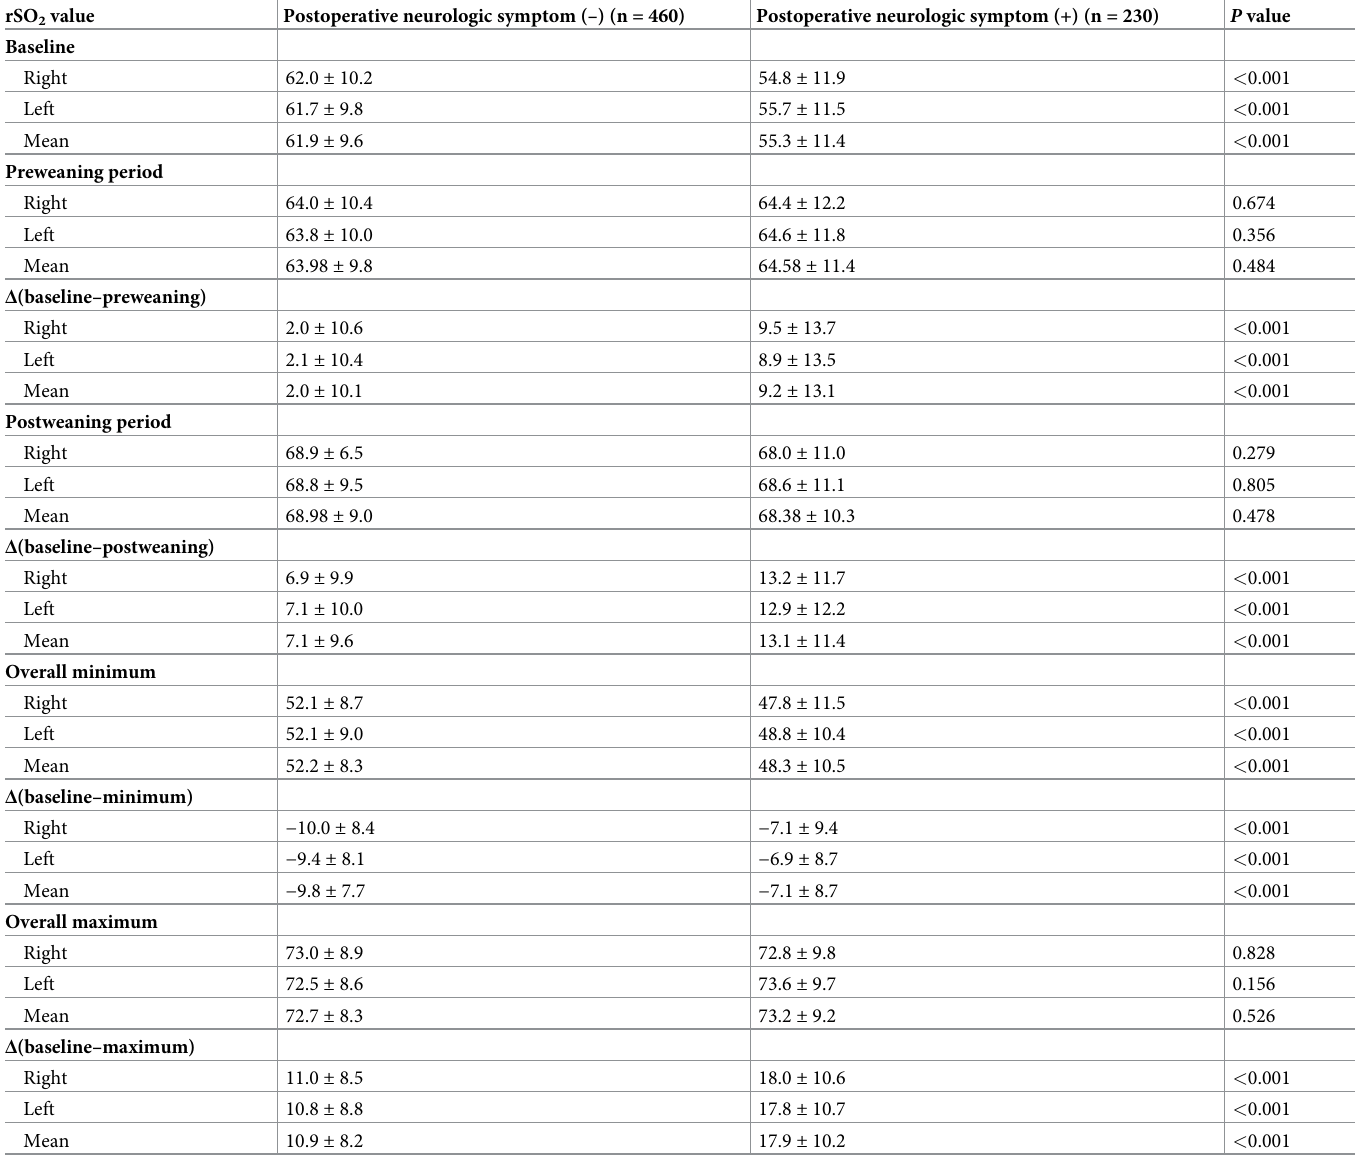
Table 2. rSO 2 values during the operation